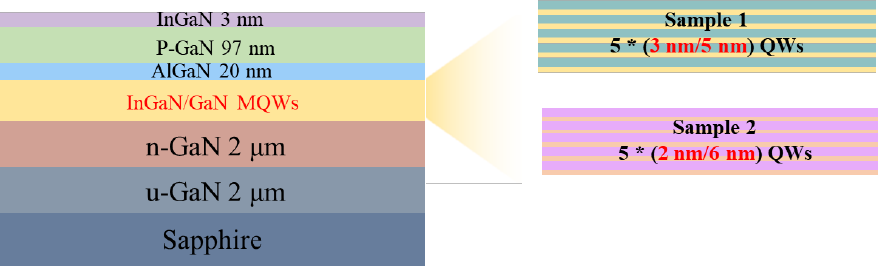
Figure 1. Schematic structure of Sample 1 and Sample 2.